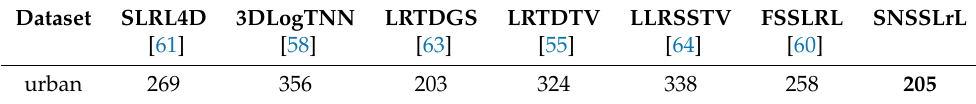
Table 4. Execution time (seconds) comparison of the competing methods on urban dataset.